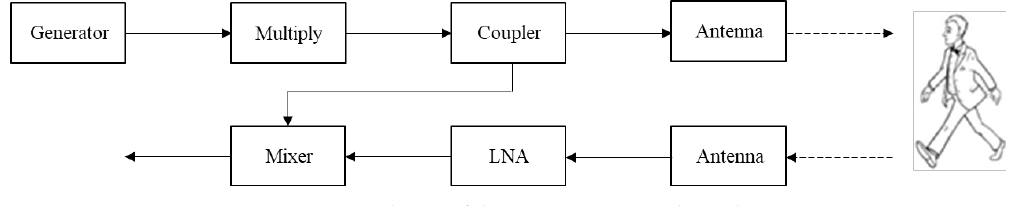
Figure 3. A scheme of the CW micro-Doppler radar.